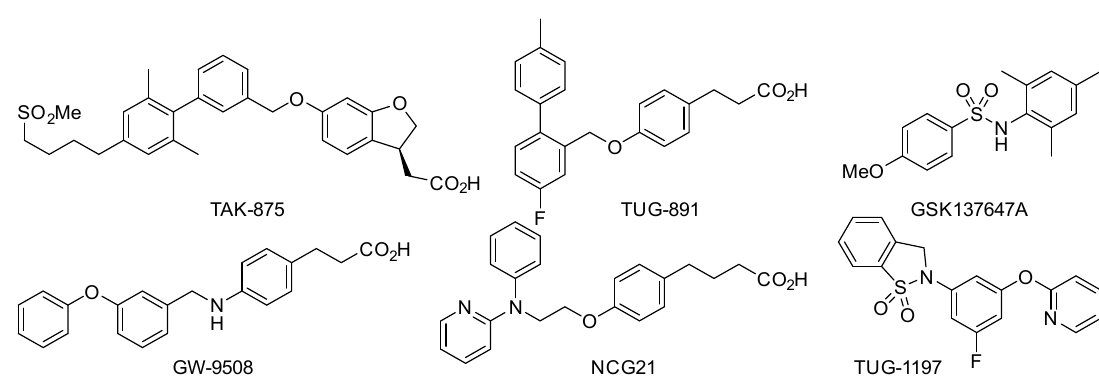
Figure 1. Structures of the reported GPR120 agonists